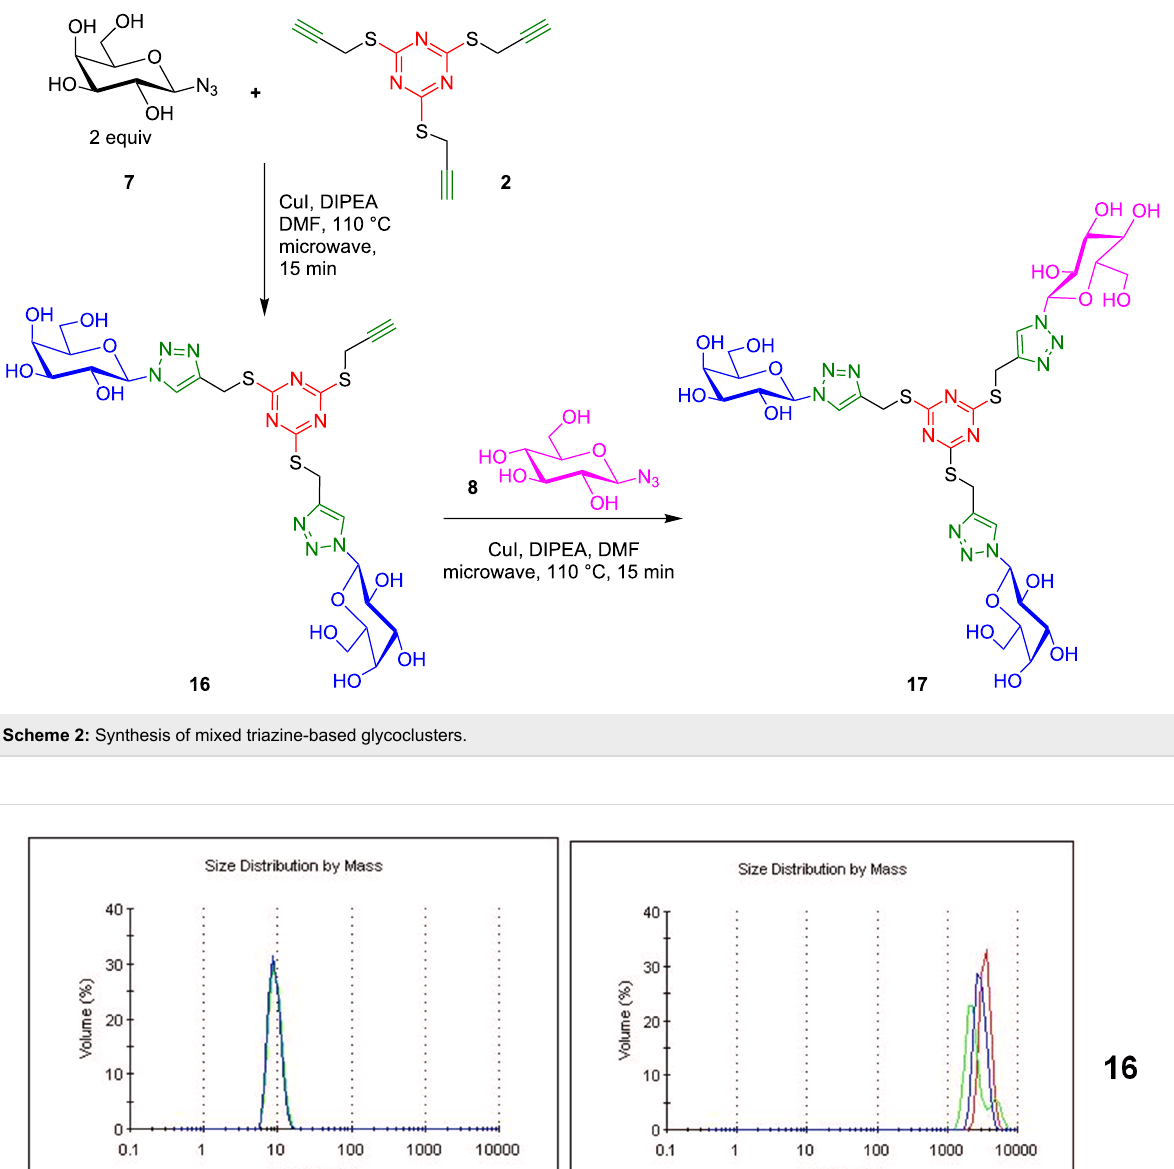
Figure 2: Dynamic light scattering experiments of bis-D-galactosyl proparyl cluster 16 with lecA. Distribution by mass for lecA + buffer (left) and lecA + 16 (200 μ M, right) at 3 minute intervals. Additional experiments can be found in Supporting Information File 1.